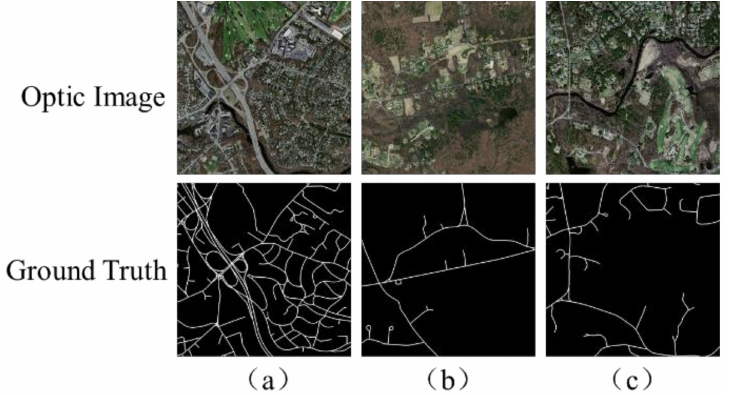
Figure 3. Examples of the Massachusetts roads dataset.: ( a ) town area, ( b ) rural area, ( c ) river